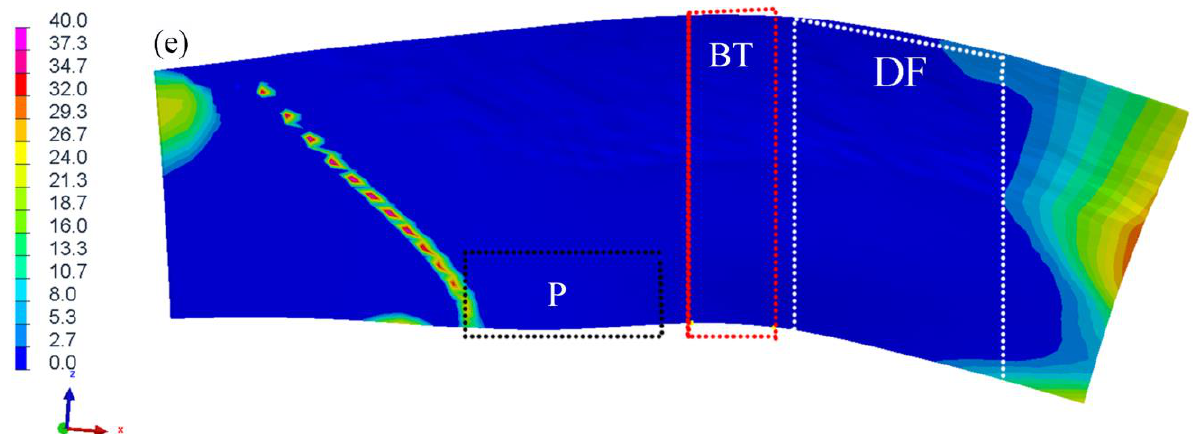
Figure 15. Simulation results of 24E-1: ( a ) experimental temperature distribution vs. the numerical result in the transverse section (°C); ( b ) temperature distribution in the longitudinal direction (°C); ( c ) plastic strain distribution in the longitudinal direction; ( d ) von Mises stress distribution in the longitudinal direction (MPa); ( e ) first principal stress distribution (MPa).